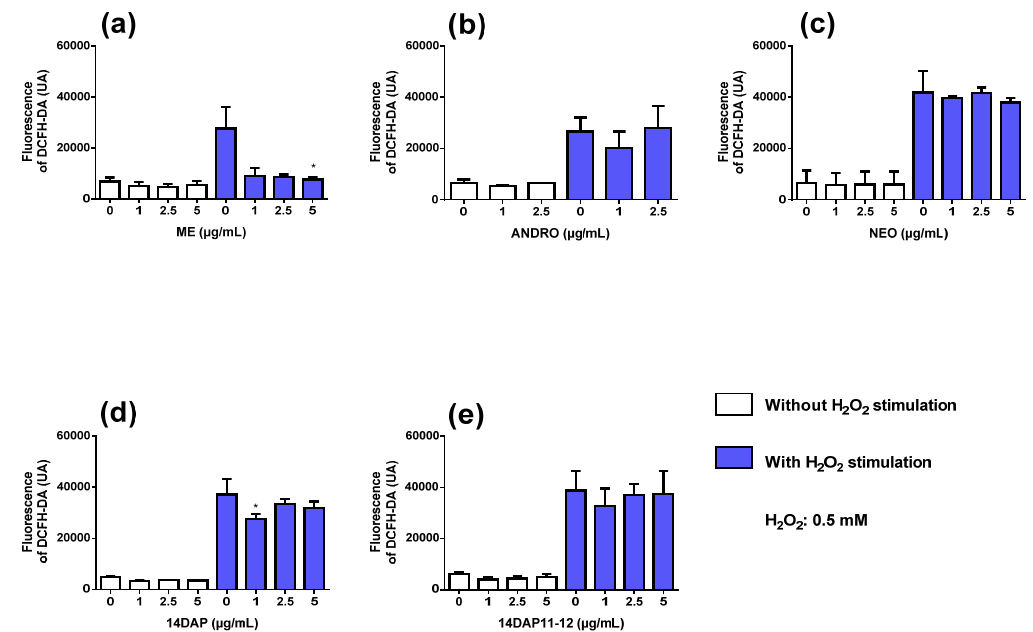
Figure 3. ROS production and the effect of ME, ANDRO, NEO, 14DAP, and 14DAP11 ‐ 12 in HaCaT. ME ( a ), ANDRO ( b ), NEO ( c ), 14DAP ( d ), or 14DAP11-12 ( e ) was used at 1, 2.5, or 5 µ g / mL for 1 h. The control cells were treated with 0.05% DMSO (noted as “0”). ROS production was induced by 0.5 mM H 2 O 2 and free radical scavenging activity was done using a DCFH-DA probe. The values are mean ± SD, * p < 0.05 compared with control group, n = 3. Abbreviations: ROS, reactive oxygen species; DCFH ‐ DA, 2 ′ ,7 ′‐ dichlorofluorescein diacetate.